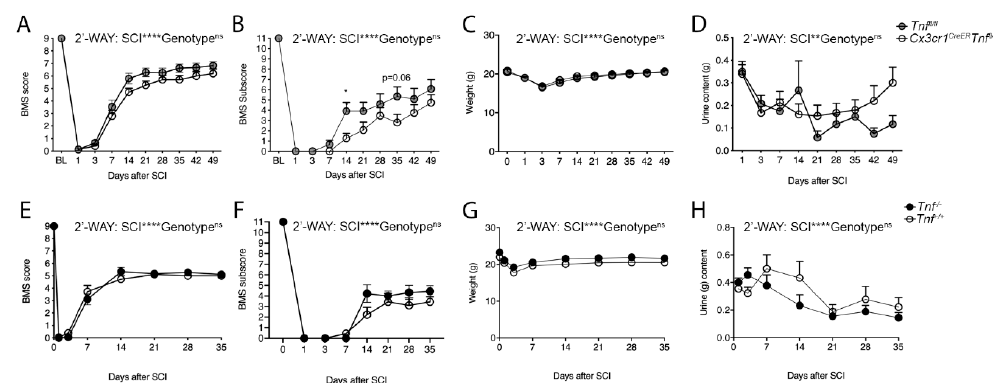
Figure 4. Conditional ablation of microglial-derived TNF and conventional TNF deletion do not affect motor function after SCI. ( A ) BMS scores in Cx3cr1 CreER Tnf fl/fl and Tnf fl/f mice demonstrating similar